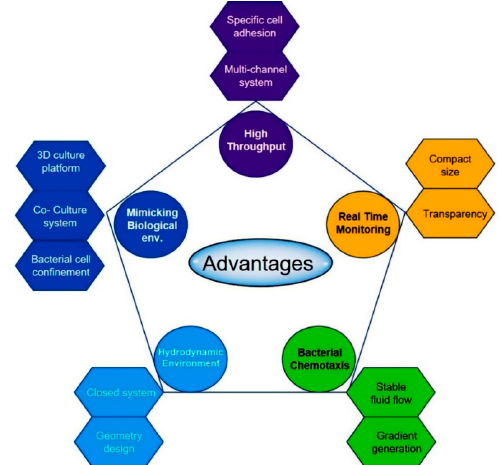
Figure 5. Advantages of a microfluidic approach for biofilms formation and eradication. Microfluidics provides unprecedented control over the flow condition, accessibility to real-time observation, high throughput testing and in vivo like environment. The microfluidic approach helps to understand the mechanism underlying biofilm formation and to identify the